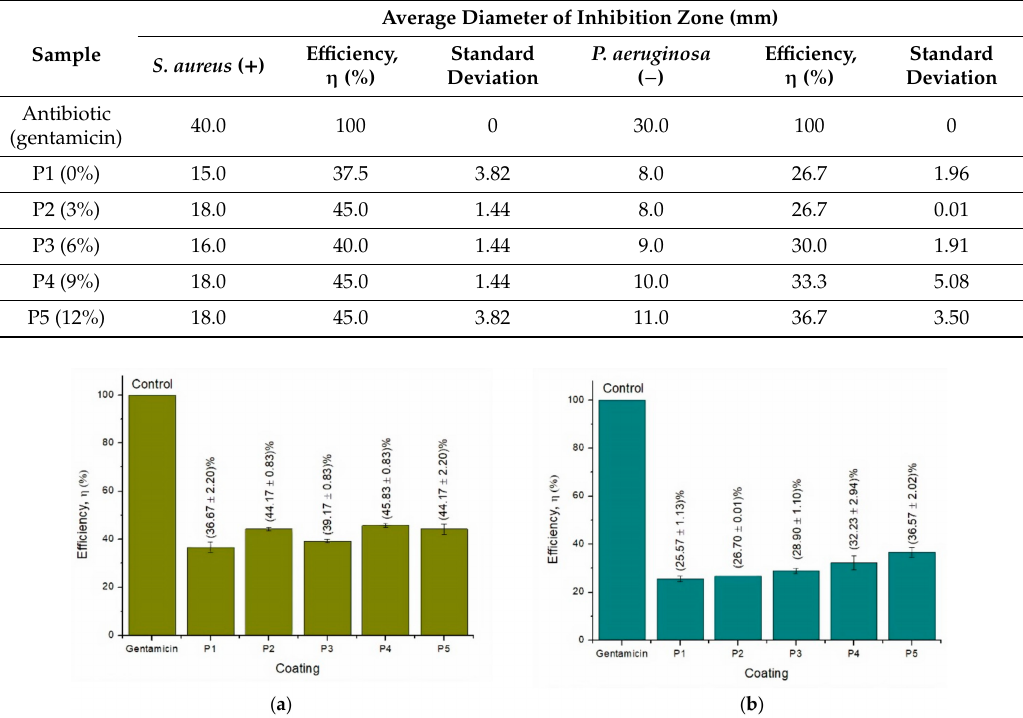
Figure 11. Inhibition e ffi ciency of di ff erent coatings against the ( a ) S. aureus ( + ) and ( b ) P. aeruginosa ( − ) bacteria.